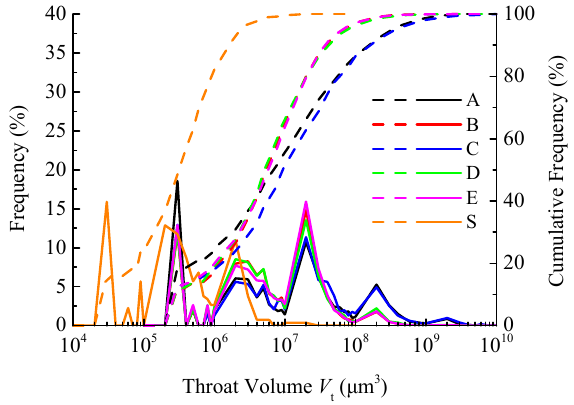
Figure 18. Distribution of throat volume in the REV2s of test samples.